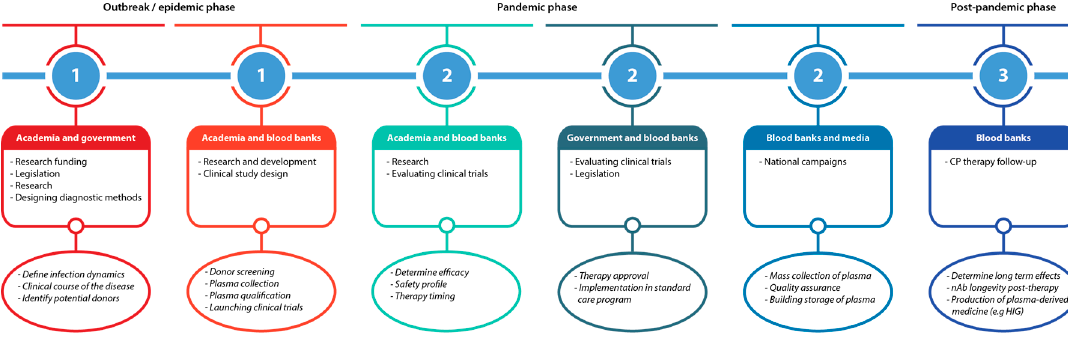
Figure 2. Flowchart of the pandemic preparedness program.